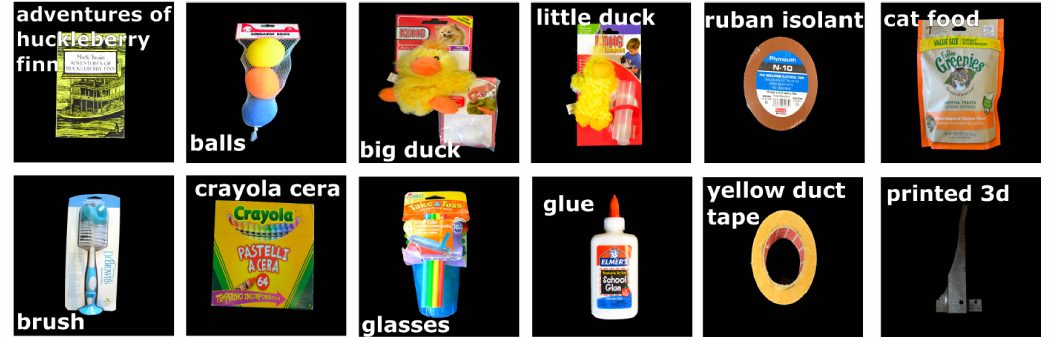
Figure 19. Set of unknown items. These items are only available 30 min before each test.